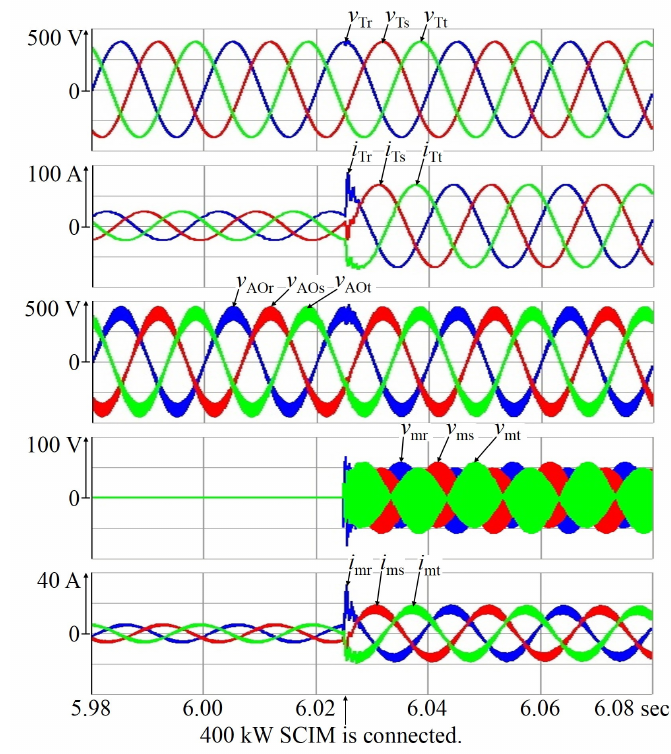
Figure 11. Simulation waveforms with the proposed inrush current suppressor for the 400-kW